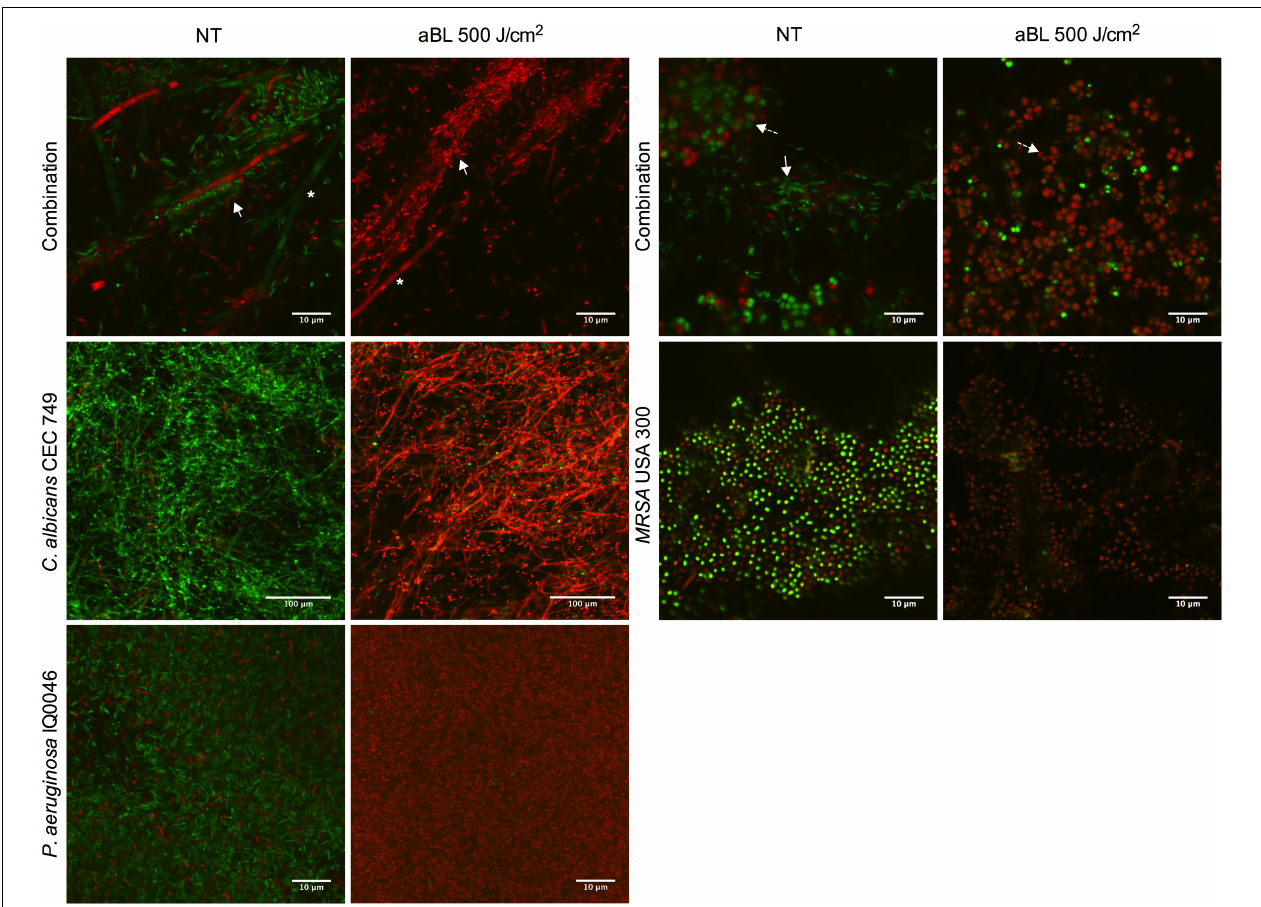
FIGURE 1 | Confocal laser microscope images showing the cytotoxic activity of aBL in P. aeruginosa IQ0046, MRSA USA300 and C. albicans CEC 749 mono and polymicrobial biofilms. Scale bars represent 10 or 100 µ m. NT, no treatment; aBL, biofilm treated with 405-nm aBL (92.6 mW/cm2, 500 J/cm 2 ). In the polymicrobial biofilms, ∗ indicate C. albicans CEC 749, solid white arrows indicate P. aeruginosa IQ0046 and dashed line arrows indicate MRSA